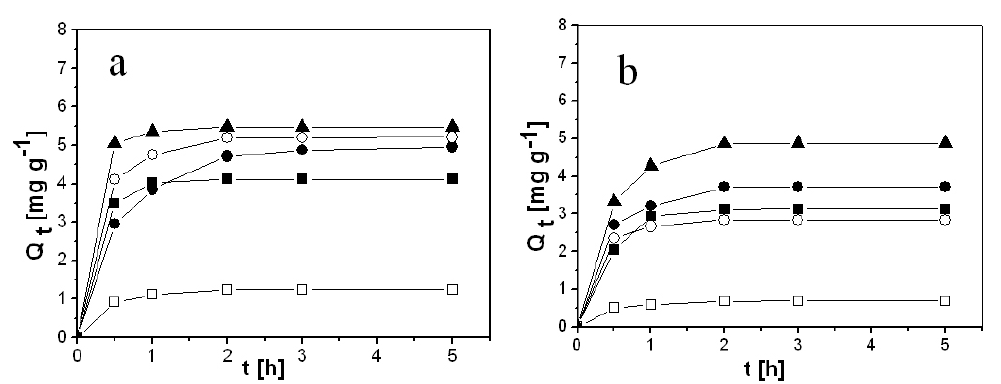
Figure 8. Effect of contact time on the amount of adsorbed Fe(III)- ■ , Cr(III)- ● , Cd(II)- □ , Cu(II)- ○ and Pb(II)- ▲ ions (C on a)Si-10B and